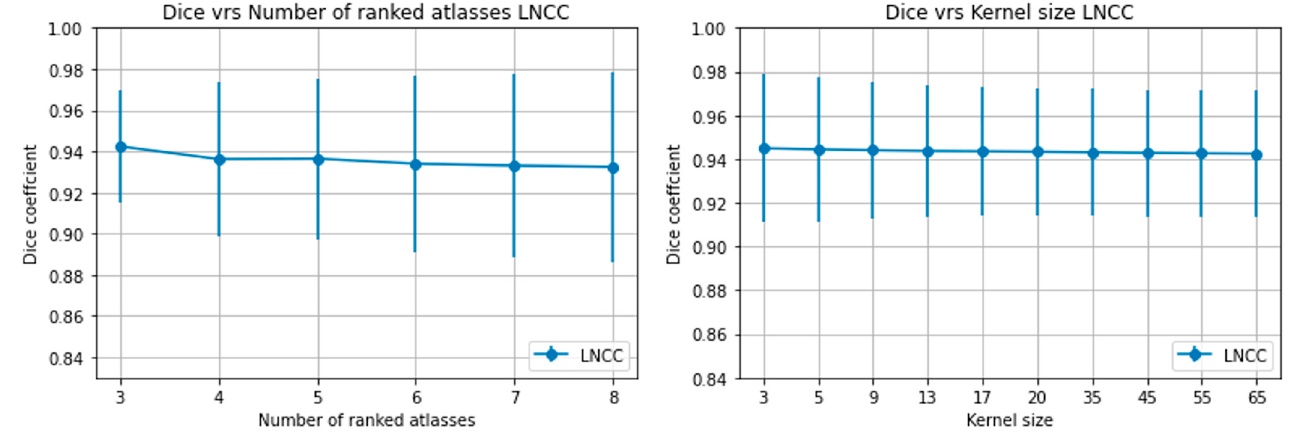
Figure 4. ( a ) Plot of Dice coefficient against number of highest ranked atlases (r) for a fixed kernel size = 5 voxels and ( b ) dice coefficient against kernel size (k) for a fixed r = 3 for the knee. Table 3. Segmentation evaluation criteria results (Mean ± SD) over the leave-one-out cross-validation for the 2 joints using LNCC (k = 5, r = 3).